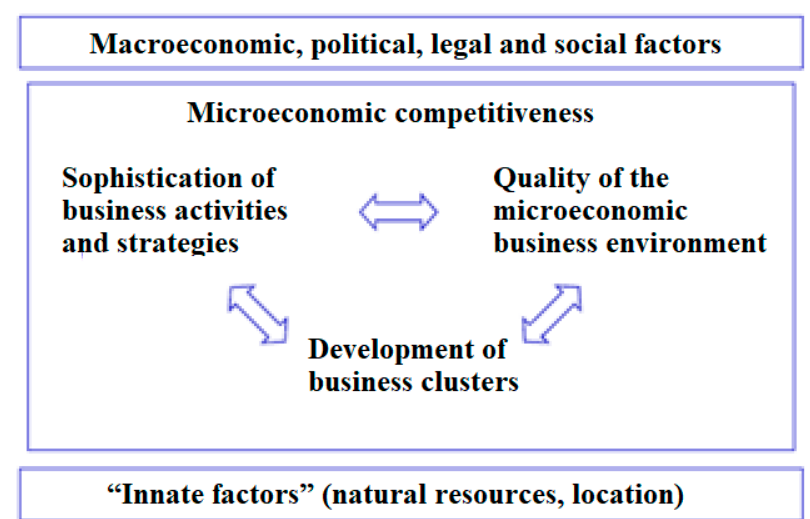
Figure 1. Factors of competitiveness [1,11].